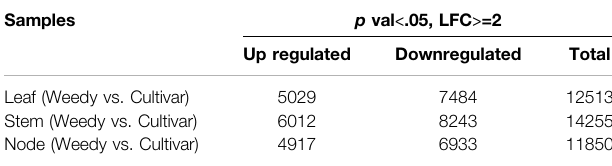
TABLE 2 | Status of differentially expressed genes between weedy and cultivar types ( p -value < .05). Samples